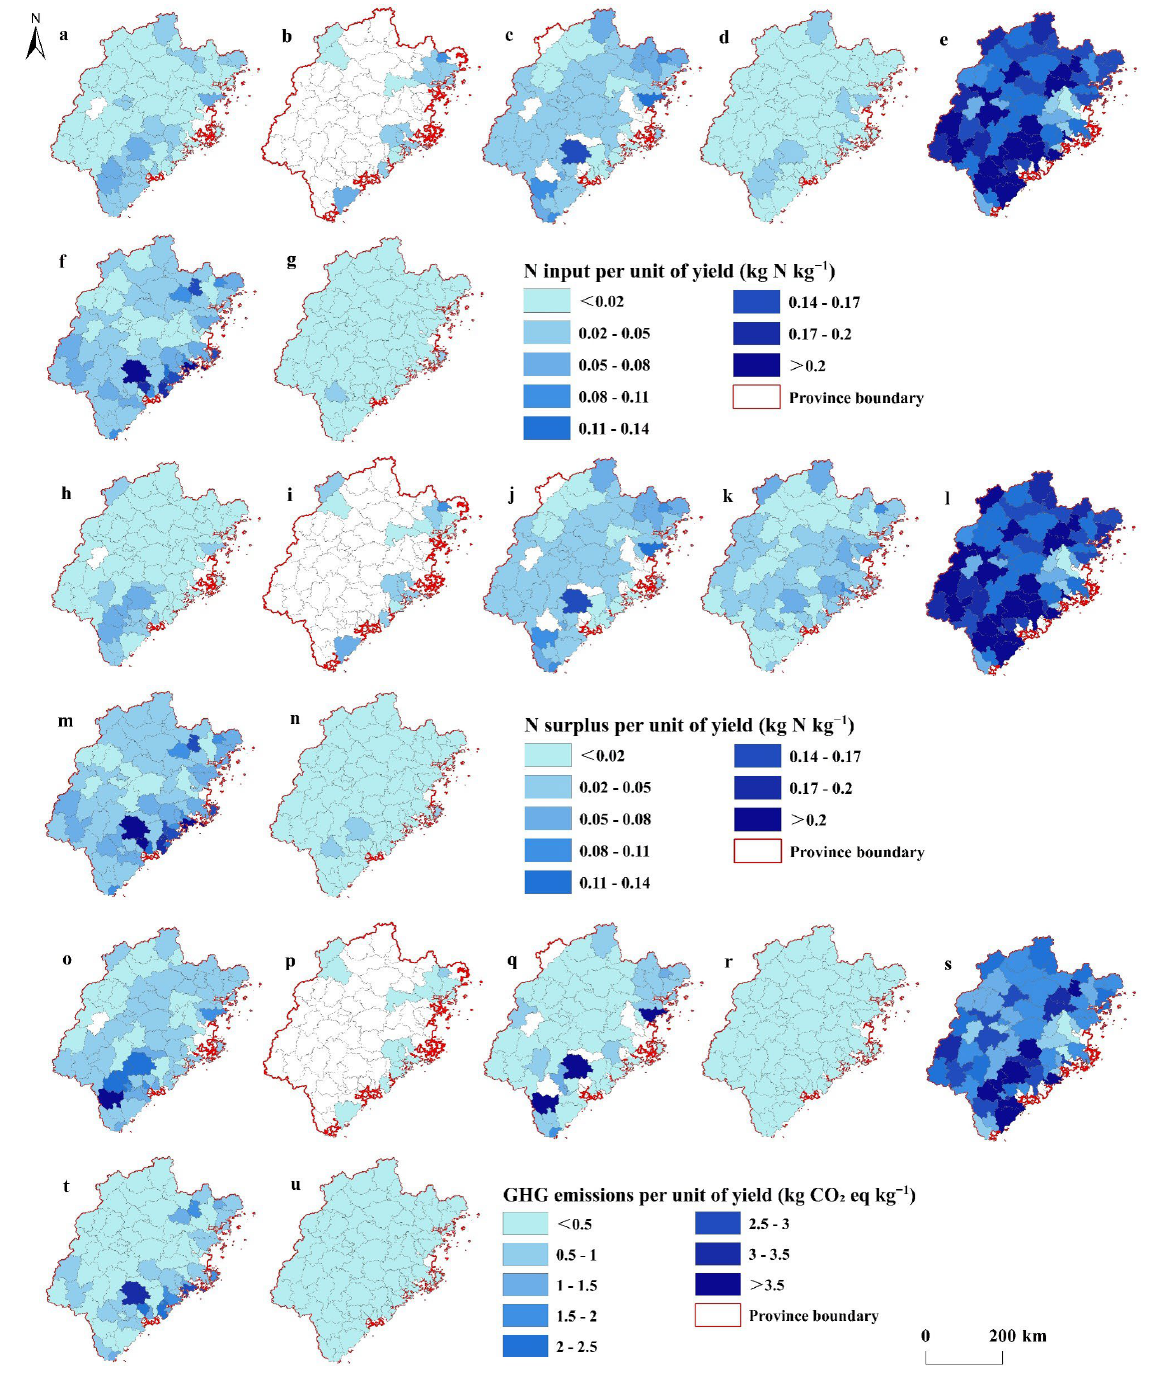
Figure 3. The N input per unit of yield ( a – g ), the N surplus per unit of yield ( h – n ), and the GHG emissions per unit of yield ( o – u ) for rice ( a , h , o ), wheat ( b , i , p ), maize ( c , j , q ), soybeans ( d , k , r ), tea ( e , l , s ), fruits ( f , m , t ), and vegetables ( g , n , u ).